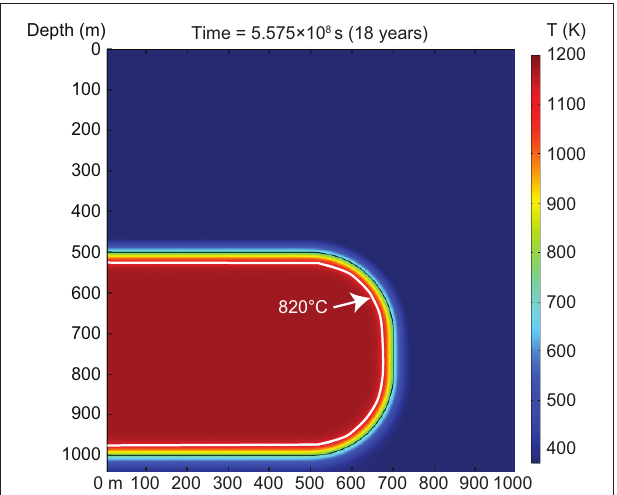
FIGURE 10 | FEM model of the extent of cooling in an axisymmetric 700m long and 500m thick body after 18 years. Initial temperature of the body was set to 900 ◦ C (1173.15K). The 820 ◦ C (1093.15K) isotherm is marked by the white line and is 25m from the contact (see main text for